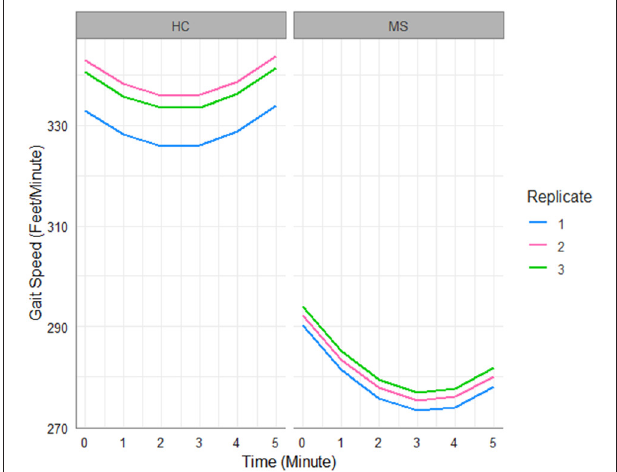
FIGURE 1 | Gait speed trajectories predicted by the fitted LME model in Table 2 .